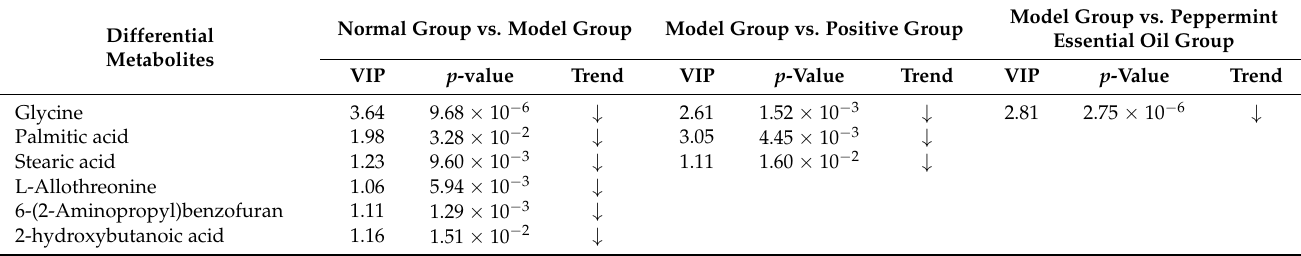
Table 5. Changes in the levels of metabolites in serum samples between normal, model, peppermint essential oil group, and positive group (VIP > 1 and p <